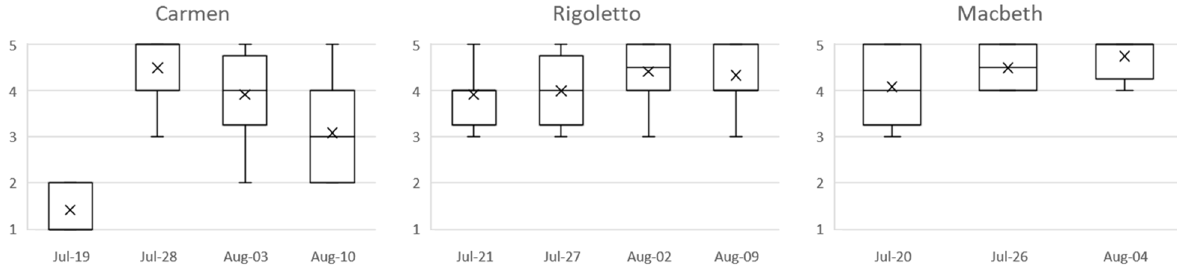
Figure 7. Customer satisfaction reported by the audience at the end of each performance.